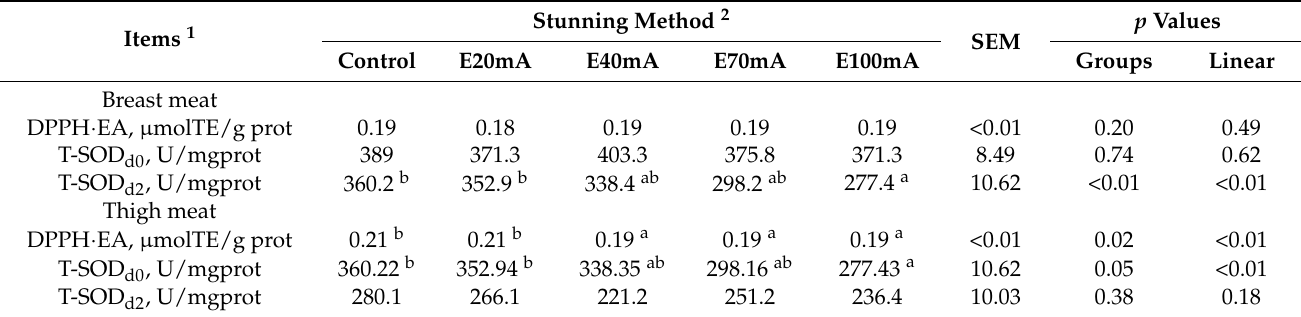
The tissue and storage time affected T-SOD activity (Figure 2). Breast meat had a higher ( n = 40, both p < 0.01) T-SOD level than thigh meat both at d 0 and d 2. Storing meat for two days reduced ( n = 40, both p < 0.01) T-SOD activity in both the breast and